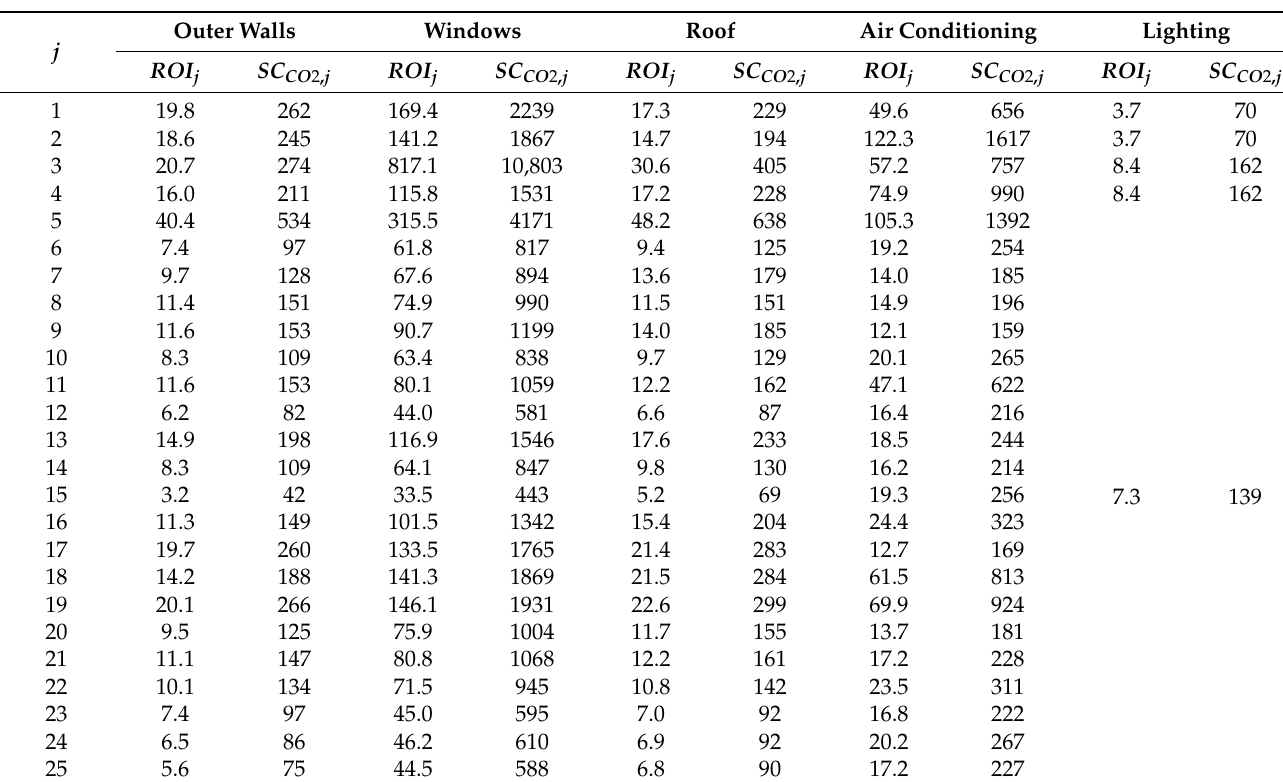
Table 5. Reevaluation of basic economic and environmental parameters of individual energy saving measures. ROI = return on investment (years), SC CO2 = specific cost of CO 2 emissions reduction ( €